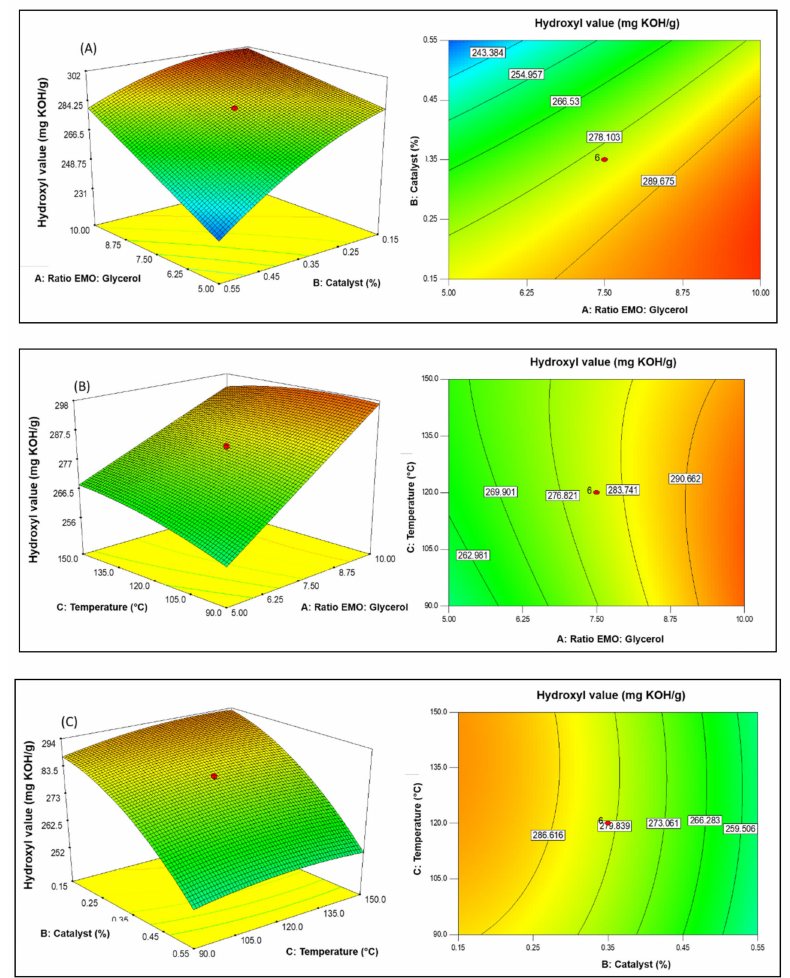
Figure 6. Response surface plots: ( A ) mole ratio (EMO:Glycerol) versus catalyst (%), ( B ) temperature ( ◦ C) versus Mole ratio (EMO:Glycerol) and ( C ) catalyst (%) versus temperature ( ◦